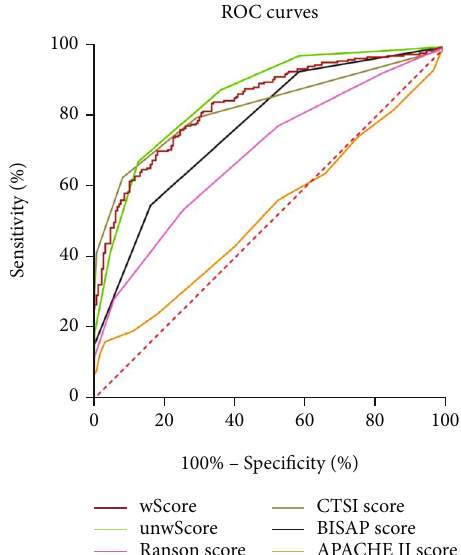
Figure 3: ROC curves of the unweighted predictive model, the weighted predictive model, and the severity scores of AP.